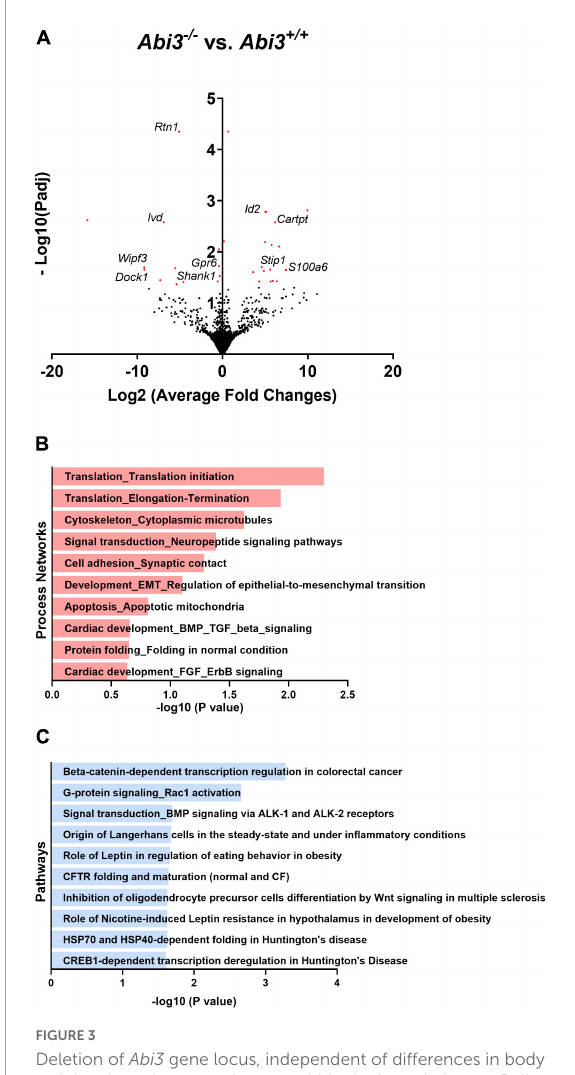
FIGURE3 Deletion of Abi3 gene locus, independent of differences in body weight, alters the transcriptome within the hypothalamus. Bulk RNA sequencing was performed with the hypothalami of 15-month-old male Abi3 + / + ( n = 4) and Abi3 - / - mice ( n = 4). Differentially expressed genes (DEGs), defined by an adjusted p -value < 0.05, were then identified. (A) Volcano plot demonstrating the DEGs from the hypothalami of Abi3 - / - vs. Abi3 + / + mice. The red points represent differentially expressed genes. (B,C) The DEGs were used to perform (B) process network and (C) pathway analysis using the Metacore software. The significantly enriched (B) process networks and (C) pathways are listed. For additional information on (B,C) the Metacore figures, see Supplementary Table 1